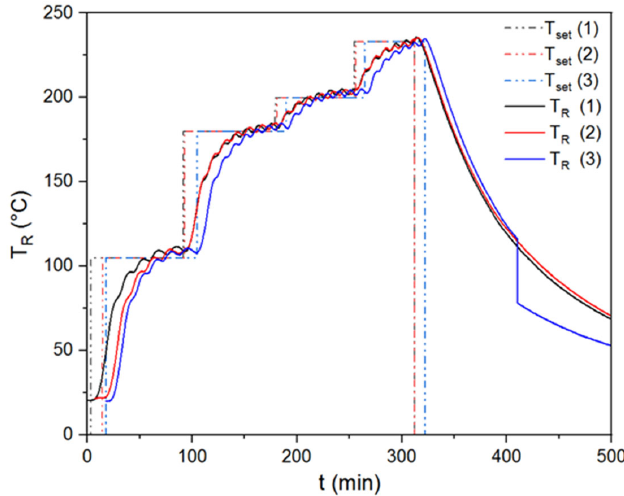
Figure 2. Repeatability tests for torrefaction experiment performed at 230 °C.